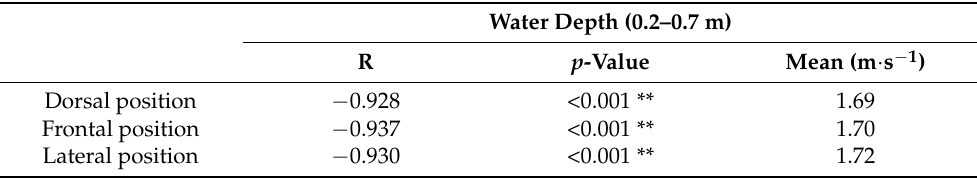
Table 1. Relationship between the swimming velocity of the three UUS positions and water depth.